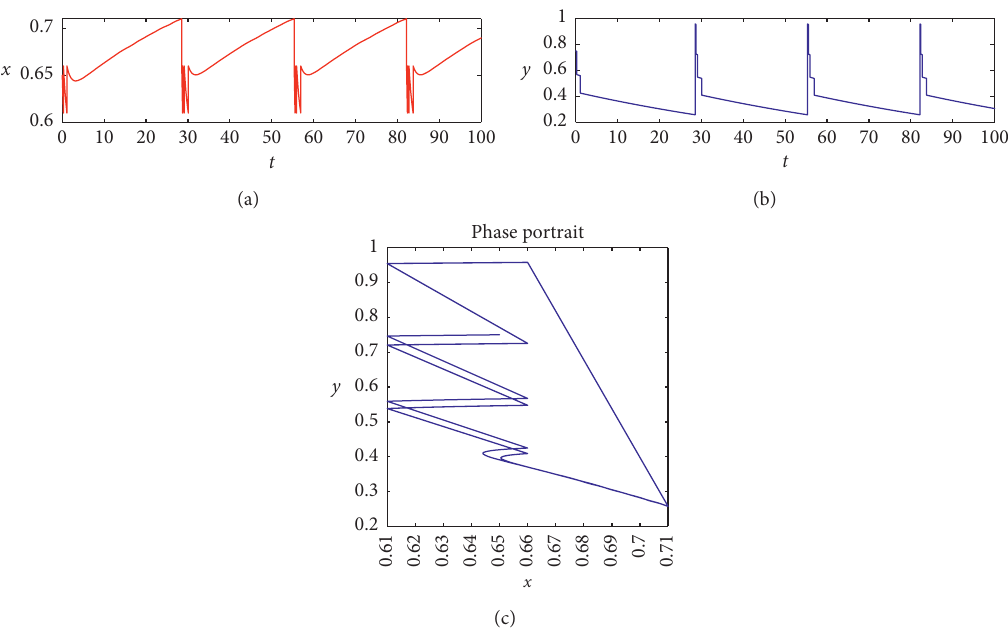
Figure 12: The order-4 periodic orbit of system (12). Control parameters: p � 0.6 and τ � 0.7. 0.50.60.70.8 x